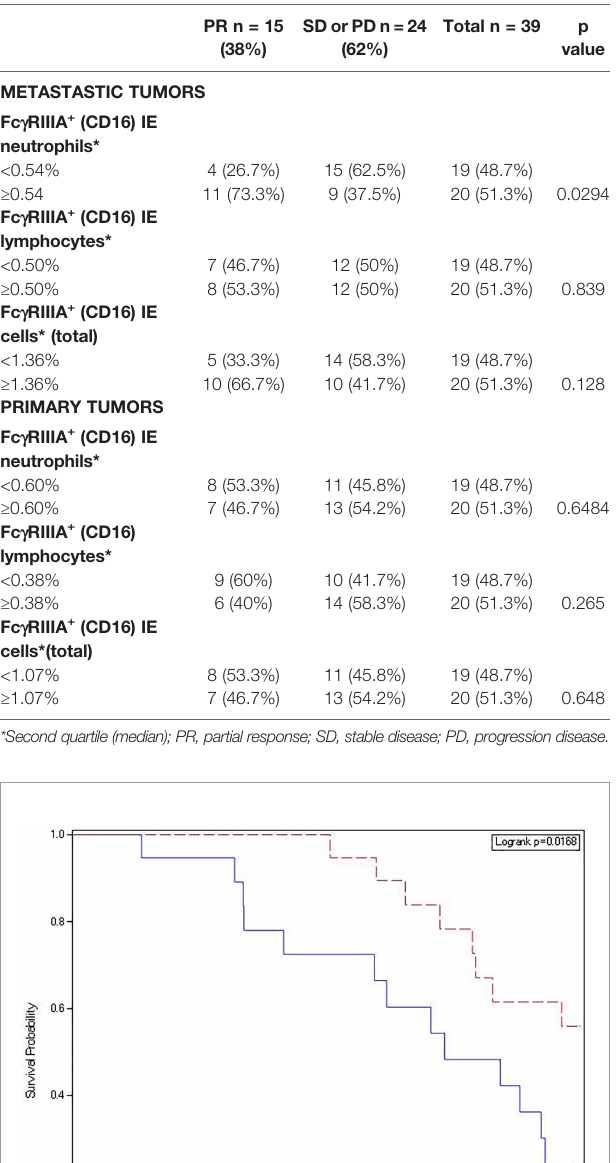
TABLE 4 | Relation between the density of Fc g RIIIA + (CD16) immune cells involved in ADCC within tumor sites and objective response to cetuximab (p Fisher ’ s exact test).